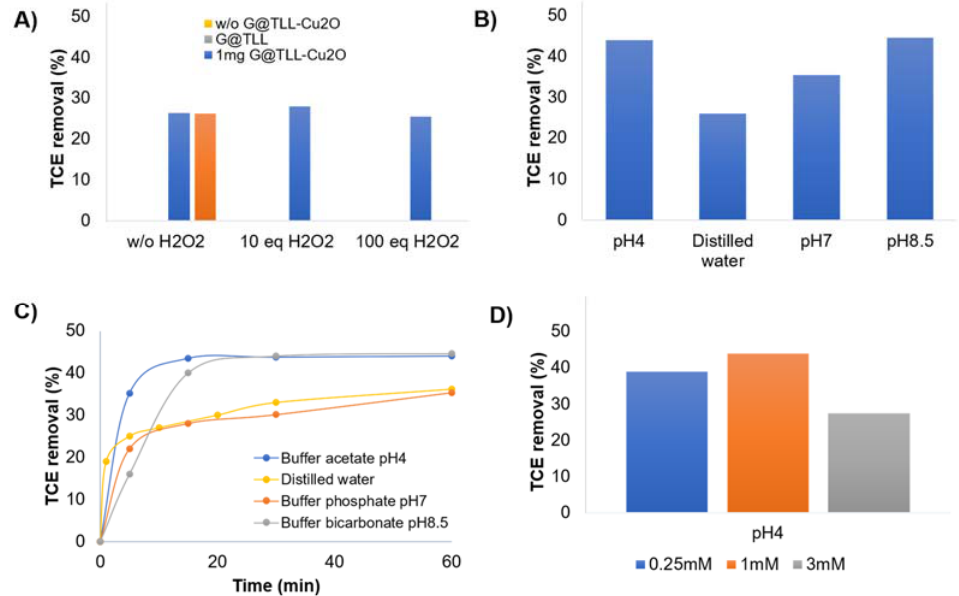
Figure 2. Degradation of 1mM of TCE in 60 min at r.t. and natural light. (A ) Evaluation with different amount of G@TLL and G@TLL-Cu 2 O (1 or 10 mg) and in the presence of different amount of H 2 O 2 (0–100eq); ( B ) Evaluation at different pH of the medium (50:50 aqueous medium: ACN) without H 2 O 2 ; ( C ) Profile at different conditions without H 2 O 2 ; ( D ) Evaluation of different amount of TCE initial at pH 4.